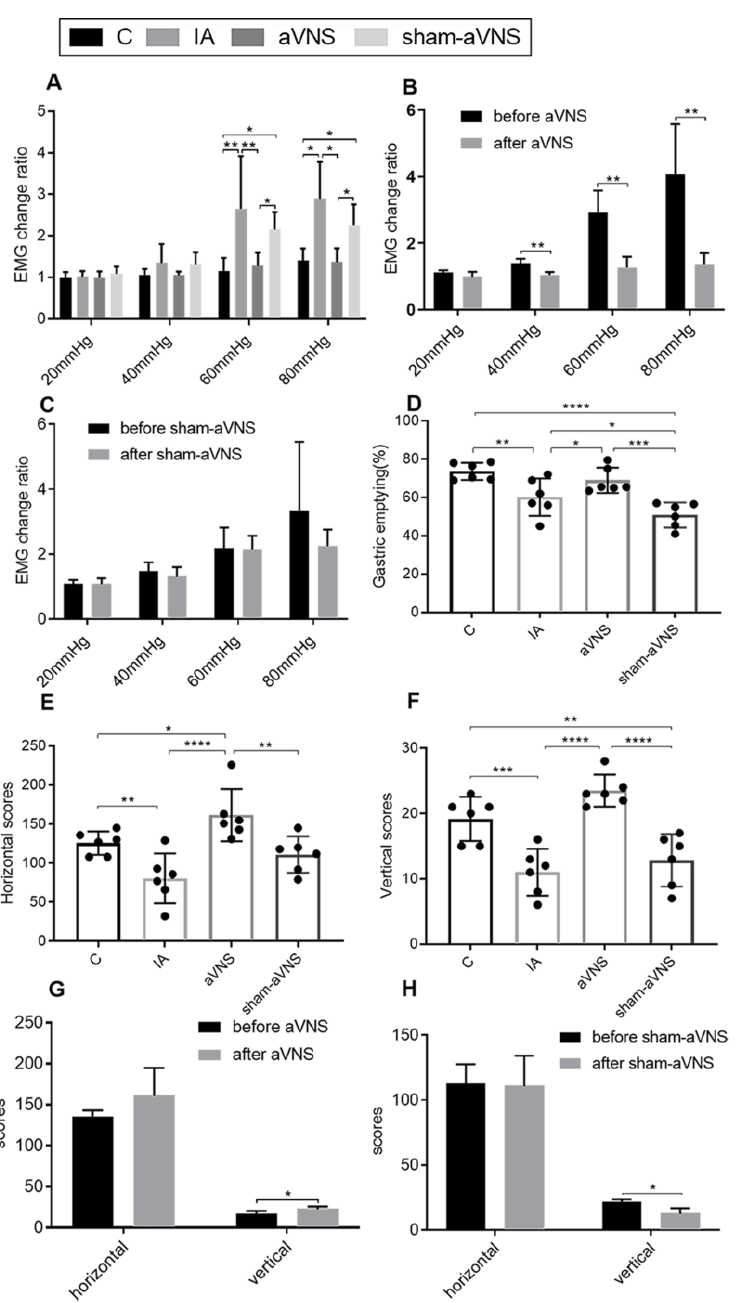
in the horizontal scores and vertical scores in Figure 3H. The aVNS relieved the depression- like or anxiety-like behavior of model rats but not the sham-aVNS.